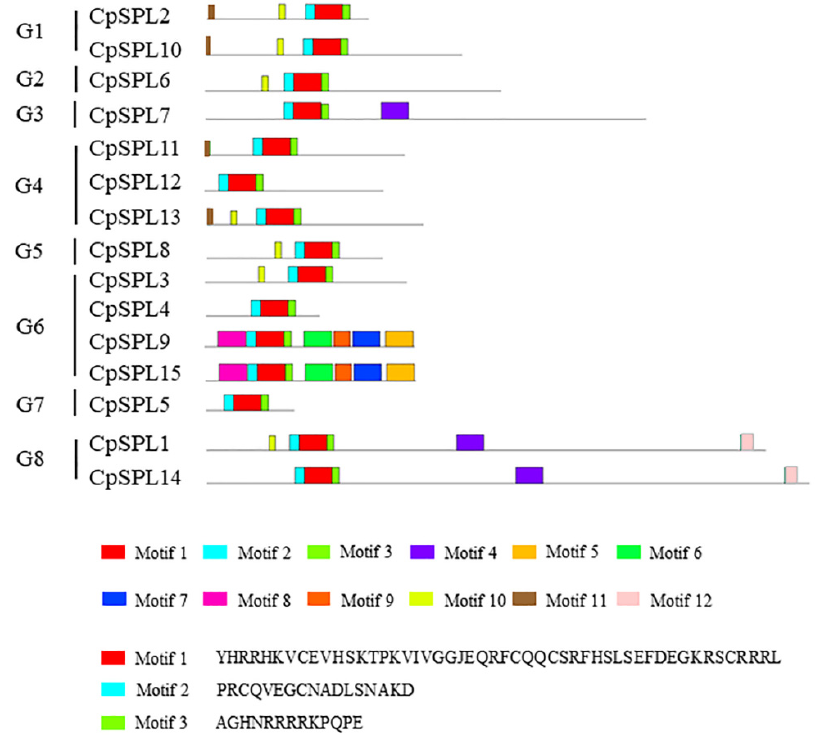
Figure 3. The analysis of conserved motifs of SPLs in Codonopsis pilosula . Left panel: eight groups based on the NJ phylogenetic tree in Figure 1. Below panel: frames in different colors represent different protein motifs, and each motif has its own